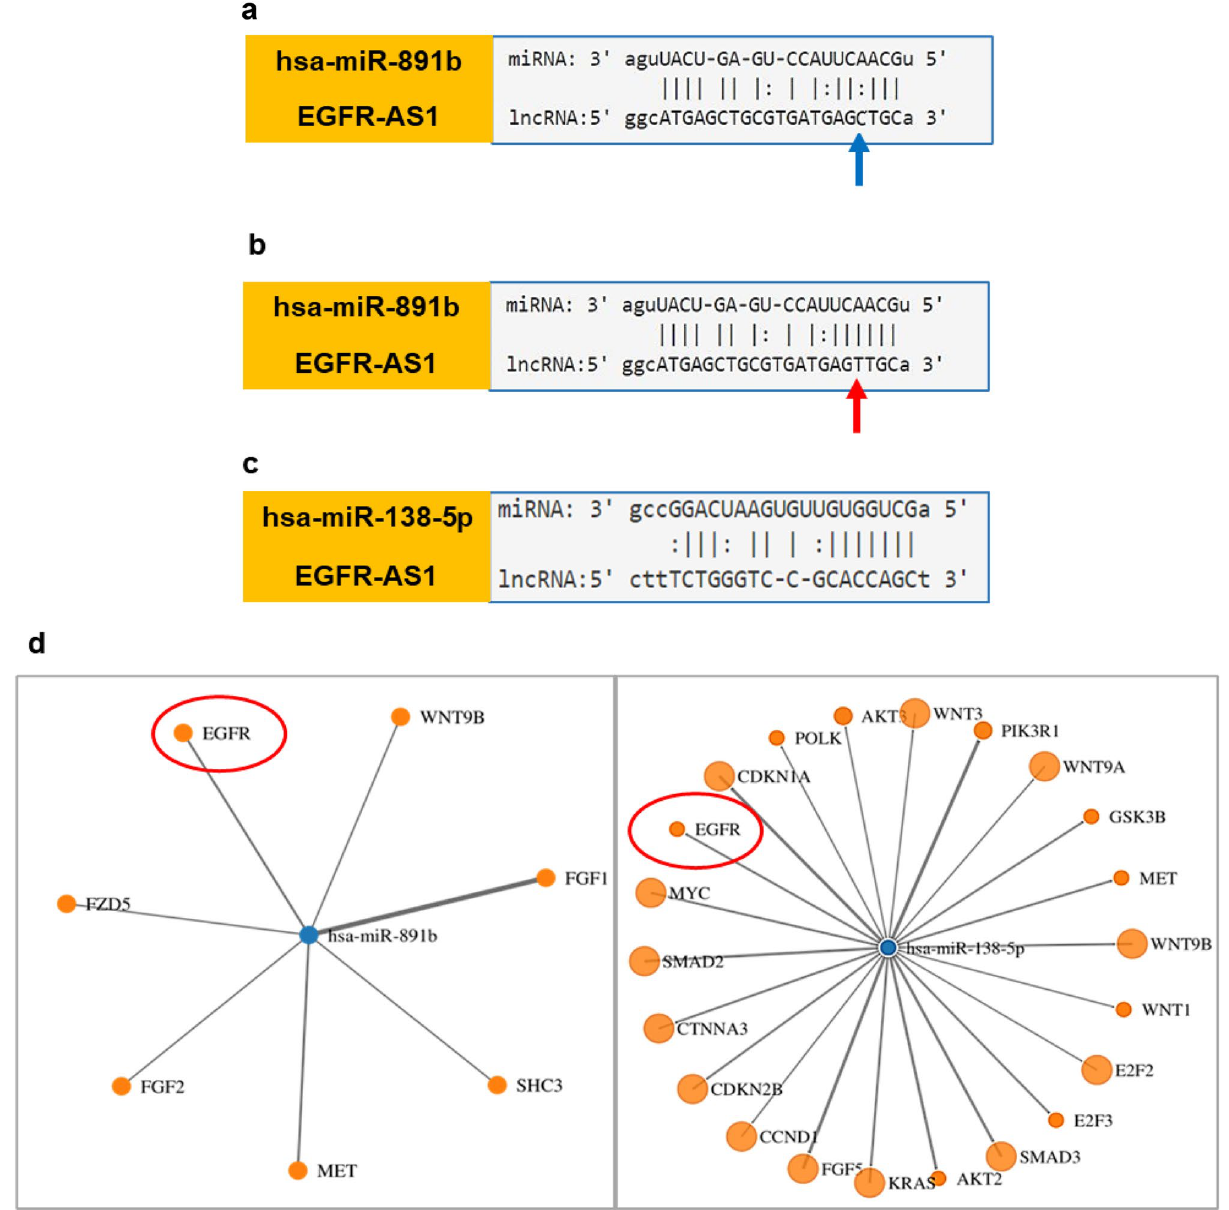
Figure 3. rs10251977 minor allele’s effect on EGFR-AS1. ( a ) Absence of minor allele in EGFR-AS1 (Blue arrow). ( b ) Prediction of effect of minor allele in EGFR-AS1 generating binding site for miR-891b using lncRNASNP2 (Red arrow indicating presence of variant allele). ( c ) Figure showing the binding site for another miRNA, miR-138-5p in EGFR-AS1. ( d ) miRWalk database showing the targets of both miR-891b and miR- 138-5p (EGFR encircled in both